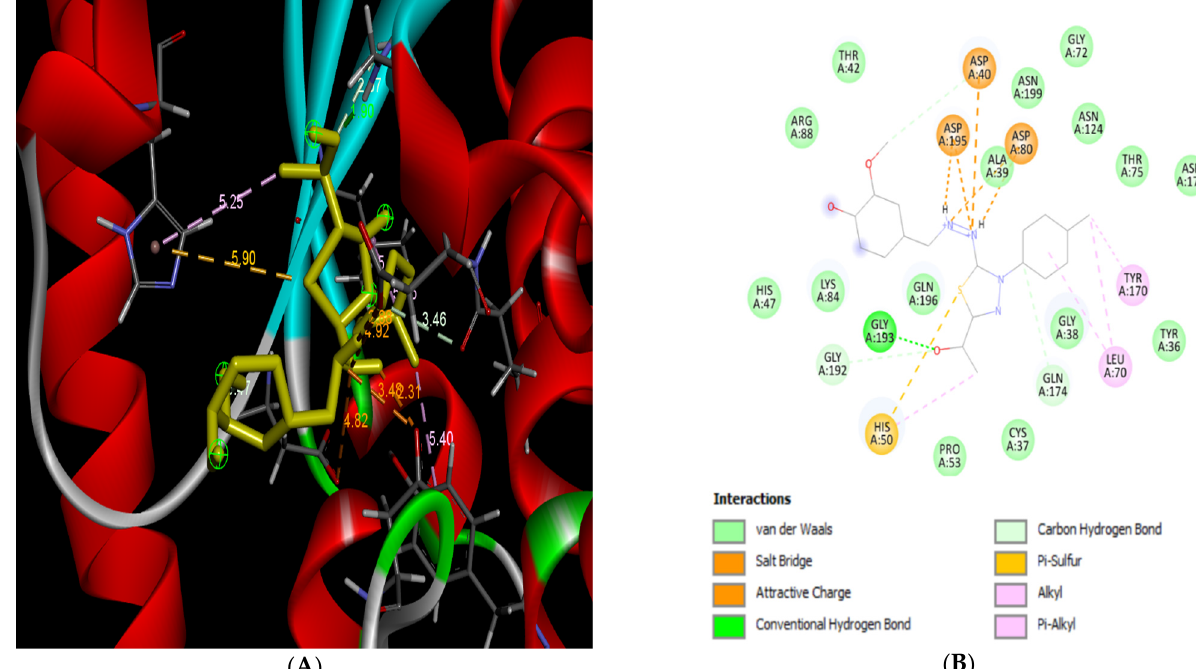
Figure 4. 2D ( B ) and 3D ( A ) representation of compound 5 docking with TyrRS. Molecules 2021 , 26 , x FOR PEER REVIEW